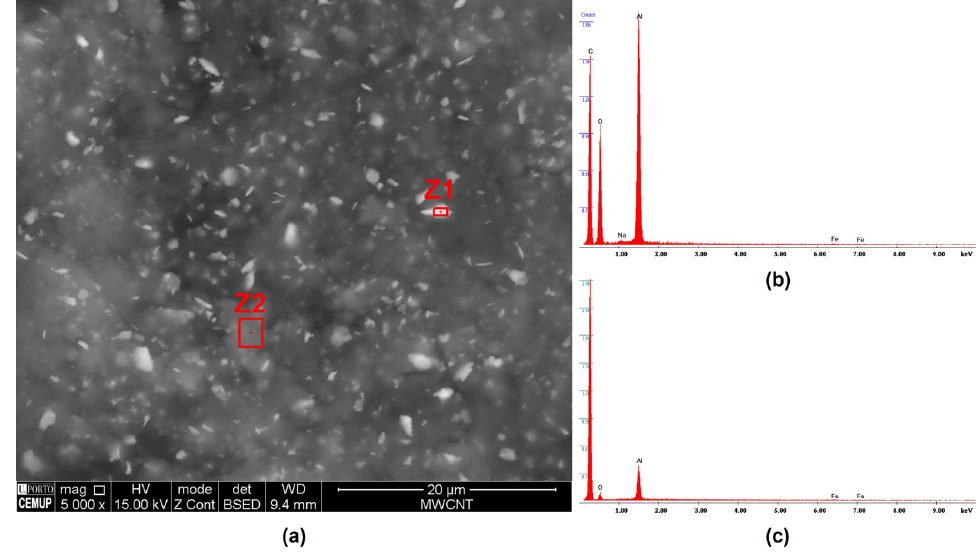
Figure 4. Detection of particles based on aluminium and iron as some of the impurities of the CCVD fabrication process of the MWCNT NC 7000. ( a ) SEM image and regions where the SEM/EDS was performed. ( b ) regions with higher amounts of aluminium oxide impurities, and ( c ) regions with lower impurities.